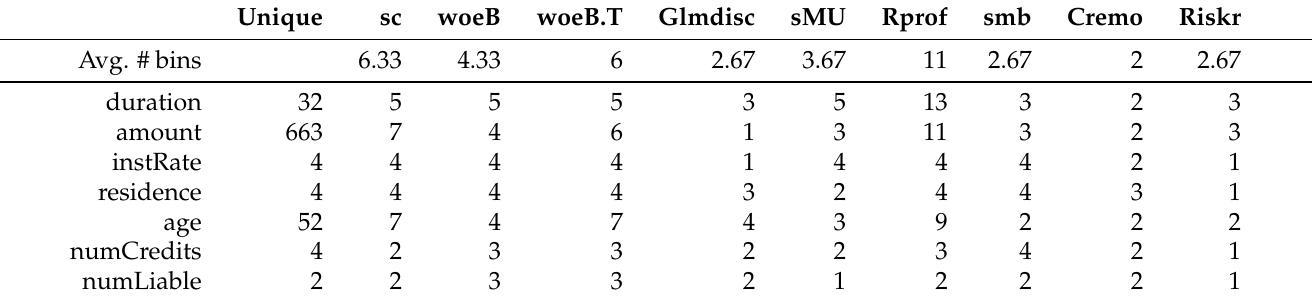
Table 1. Number of bins after automatic binning. Abbreviations of package names: sc = scorecard ; woeB = woeBinning using woe.binning() ; woeB.T = woeBinning using woe.tree.binning() ;